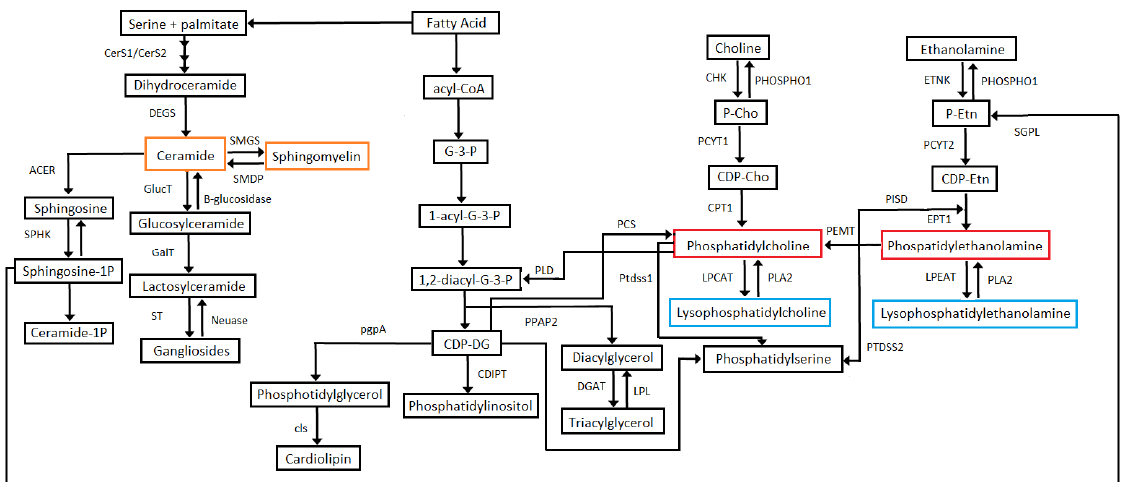
Figure 7. Schematic Representation of lipid metabolic pathways. Metabolite abbreviations: G-3-P, sn-Glycerol 3-Phosphate; 1-acyl-G-3-P, 1-Acyl-sn-glycerol 3-phosphate; 1,2-diacyl-G-3-P, 1,2-Diacyl-sn-glycerol 3-phosphate; CDP-DG, CDP-1,2-diacylglycerol; P-Cho, Choline Phosphate; CDP-Cho, CDP-choline; P-Etn, Phosphoethanolamine; CDP-Etn, CDP-ethanolamine. Enzyme abbreviations: CerS1/CerS2, Ceramide Synthase 1/Ceramide Synthase 2; DEGS, sphin- golipid delta-4 desaturase; SMGS, sphingomyelin synthase; SMDP, Sphingomyelin Phosphodiesterase; ACER, alkaline ceramidase; SPHK, sphingosine kinase; GlucT, Glucosylceramide-Transferase; GalT, Galactosylceramide-Transferase; ST, Sialyl-Transferase; Neusase, Neuraminase; pgpA, phosphatidylglycerophosphatase A; cls, cardiolipin synthase; PLD, Phospholipase D1/2; PPAP2, phosphatidate phosphatase; CDIPT, CDP-diacylglycerol-inositol 3-phosphatidyltransferase; CHK, choline kinase; PHOSPHO1, phosphoethanolamine/phosphocholine 586 phosphatase; PCYT1, choline-phosphate cytidylyltransferase; CPT1, diacylglycerol cholinephosphotransferase; PCS, phosphatidylcholine synthase; DGAT, dia- cylglycerol O-acyltransferase; LPC, lipoprotein lipase; Ptdss1, phosphatidylserine synthase 1; LPCAT, lysophosphatidyl- choline 650 acyltransferase; PLA2, secretory phospholipase A2; ETNK, Ethanolamine Kinase; PCYT2, ethanolamine- phosphate cytidylyltransferase; PISD, phosphatidylserine decarboxylase; EPT1, ethanolaminephosphotransferase; PEMT, phosphatidylethanolamine N-methyltransferase; LPEAT, lysophospholipid acyltransferase; PTDSS2, phosphatidylserine synthase 2. Lipid species analysed in the present study: Orange rectangles = sphingolipids, red rectangles = phospholipids, blue rectangles =